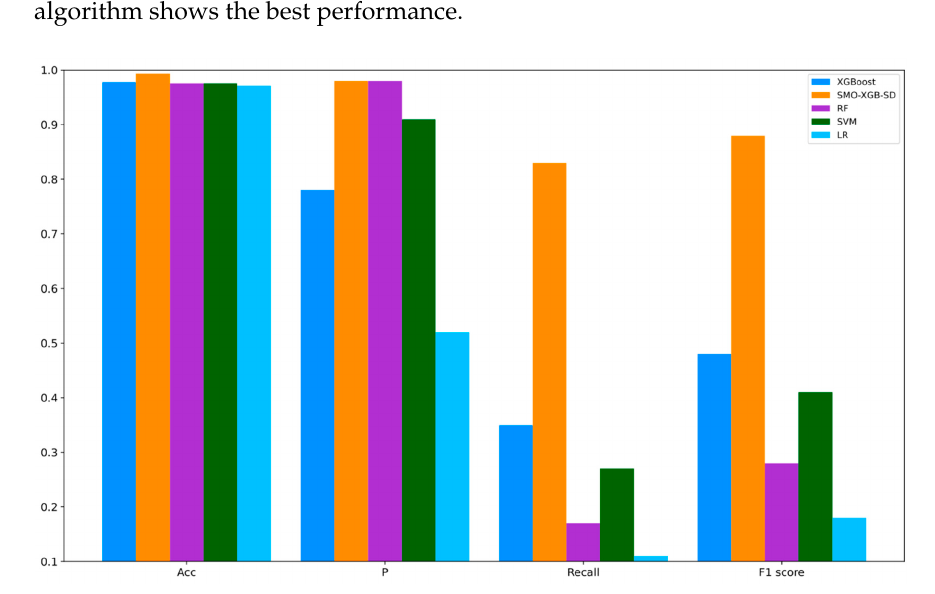
Figure 6. Comparison results of five classification algorithms.